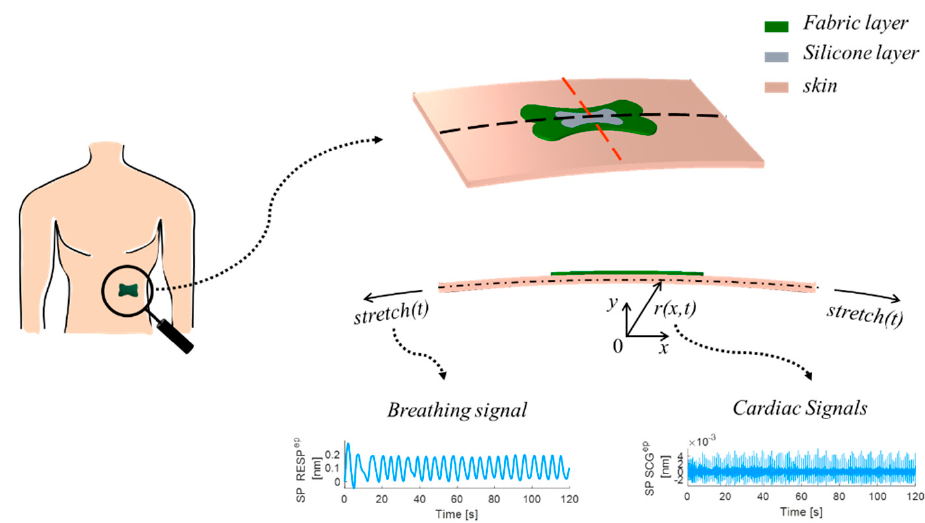
Figure 3. Schematic view of the computational model: on the left, the position of the sensor on the body; on the right, the detail of the computational domain with the boundary conditions used in the numerical analysis.